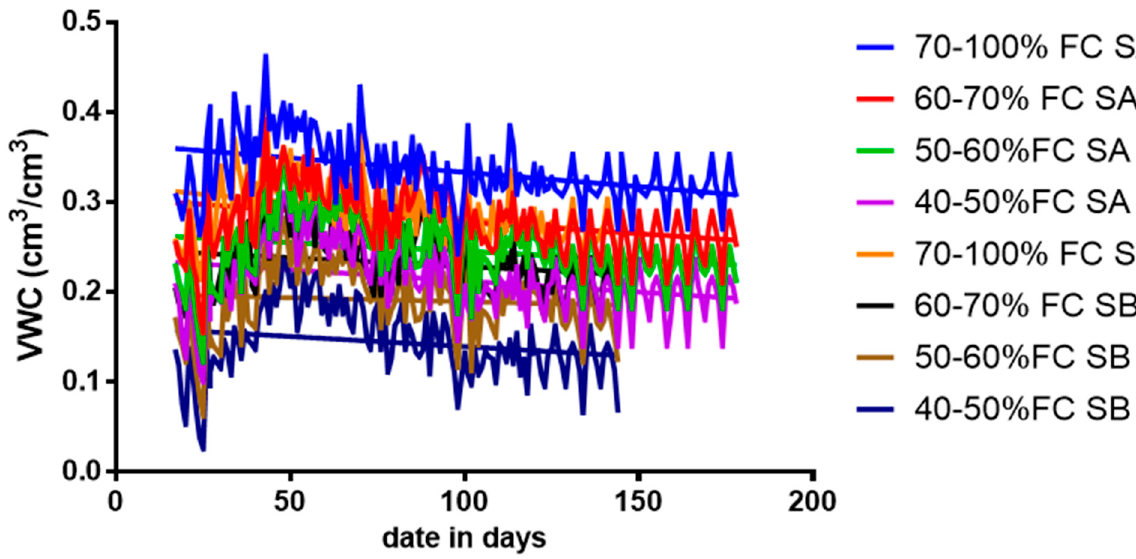
Figure 3. Disparity in the soil moisture content during the growing season for sandy loam soil and silty loam soil.